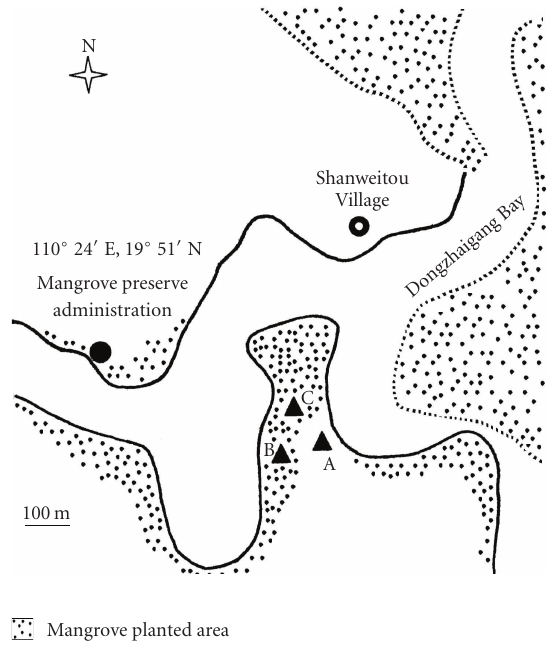
Figure 1: Map of sampling sites (A, B, and C)